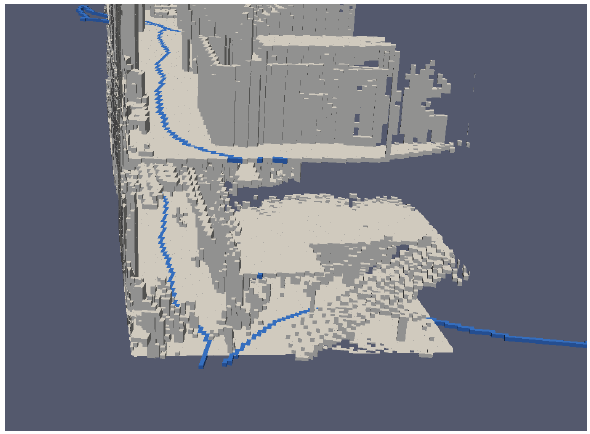
Figure 3. Identified seed voxels in the voxelized point cloud: blue corresponds with a flat